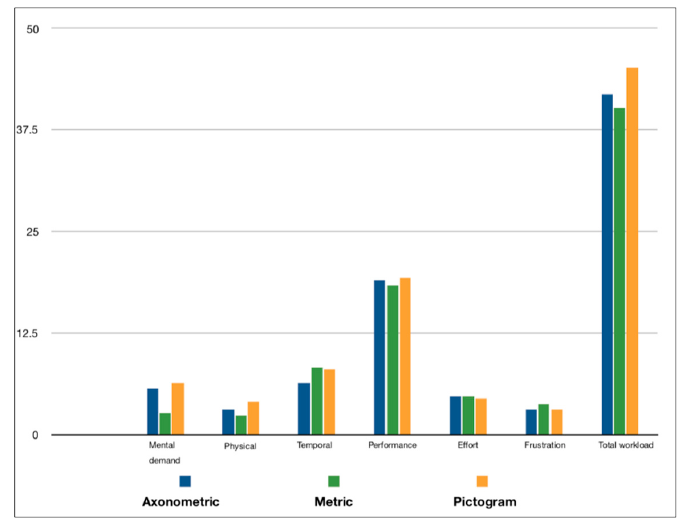
Figure 23. Cognitive workload estimates for six categories, for all the three conditions. (1. axonometric; 2. metric; 3. pictogram). Table 10. Mann–Whitney U test results for all cognitive workload categories, between all pairs